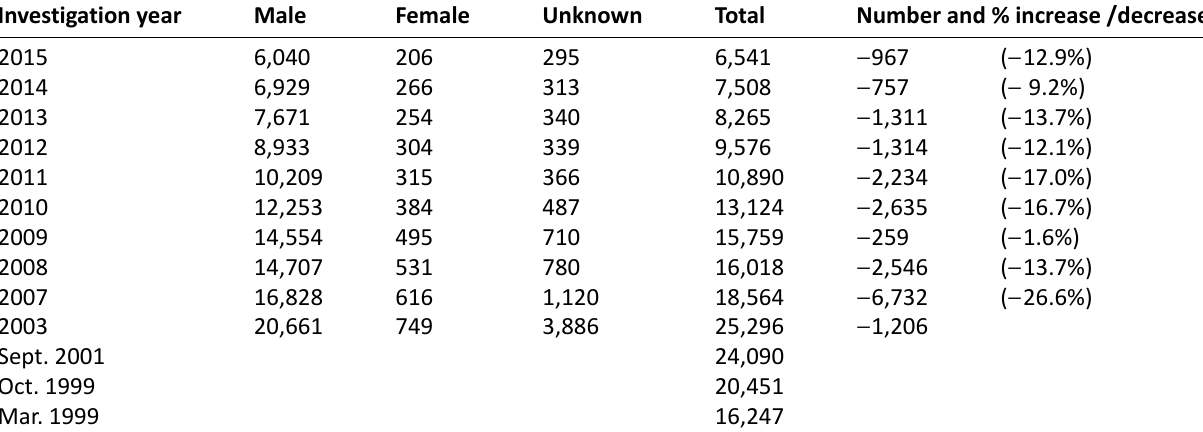
Table 3. Change of number of rough